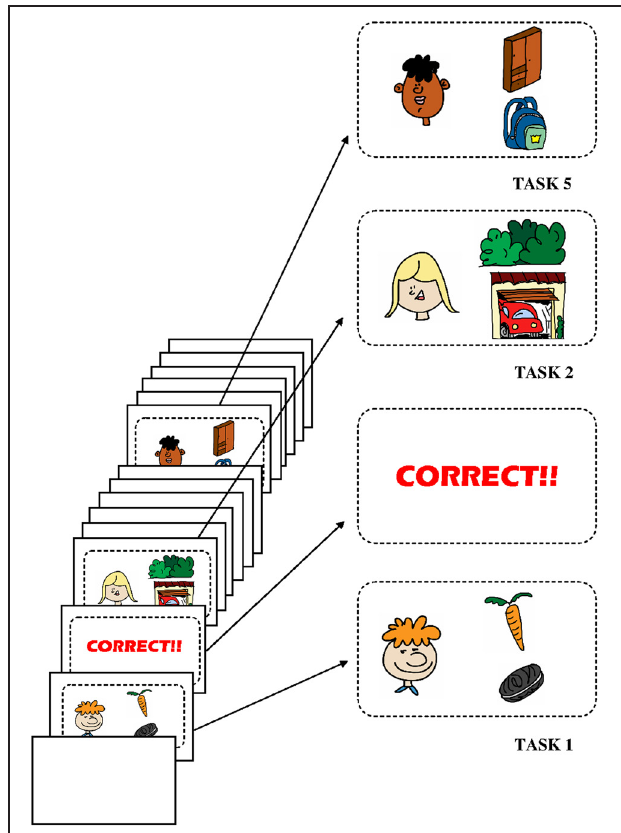
FIGURE 1 | Description of the test. The test was delivered to each child in a novel computer format. The experimenter first said to each child: “There are six levels; you will have to answer correctly in each one of them to win the game. Let’s go!” Then, for each task, the experimenter explained the task to the child, who could choose any of the options given. There were no wrong answers, such that, independently of the answer, a “CORRECT” screen appeared next. Three of the tasks are shown in the